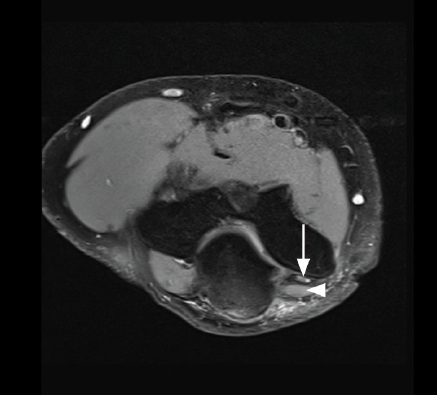
Fig. 2. Axial fat-suppressed MR image of the right elbow in patient 2, demonstrating the presence of the anconeus epitrochlearis muscle (arrowhead) and high signal in the thickened ulnar nerve